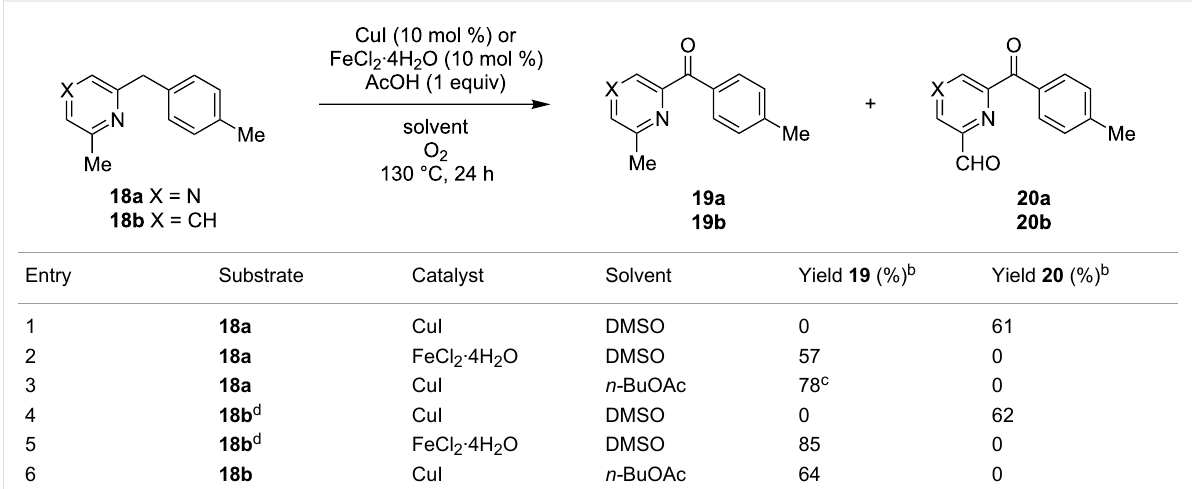
Table 5: Chemoselectivity obtained by selection of catalyst and solvent. a